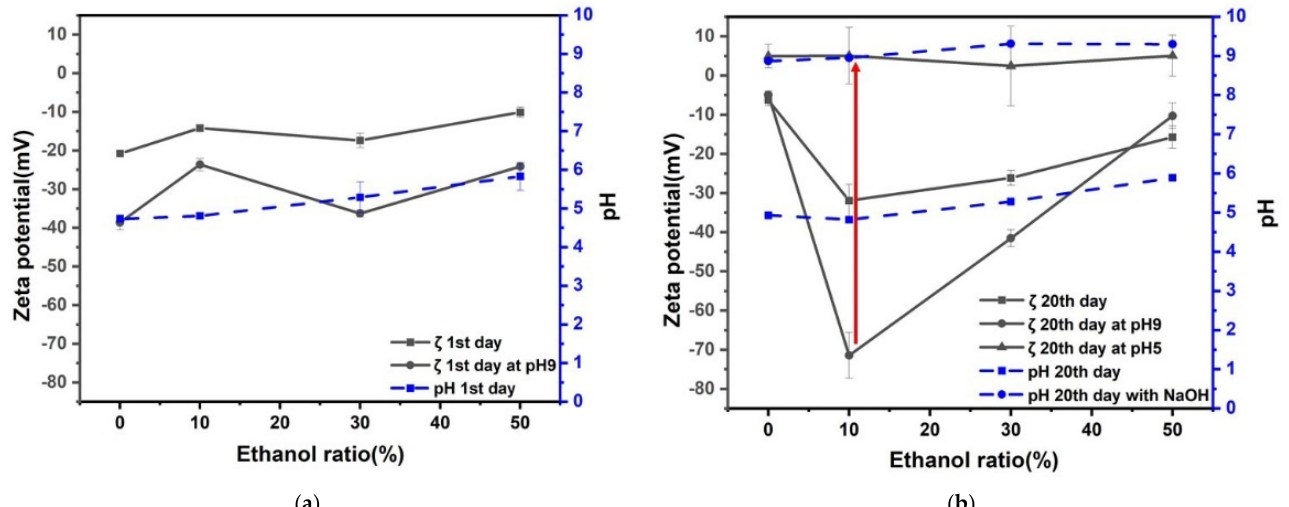
Figure 6. Zeta potential and pH of CO 2 after 8% H 2 in Ar nanobubble solution as a function of ethanol percentage of ethanol aqueous solution mixtures after: ( a ) 1 day and ( b ) 20 days.